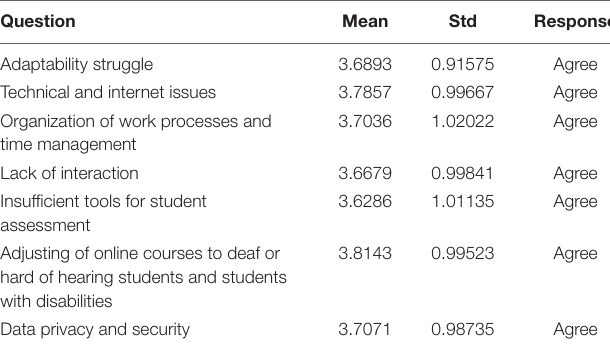
TABLE 6 | The advantages of online teaching and learning during the COVID-19